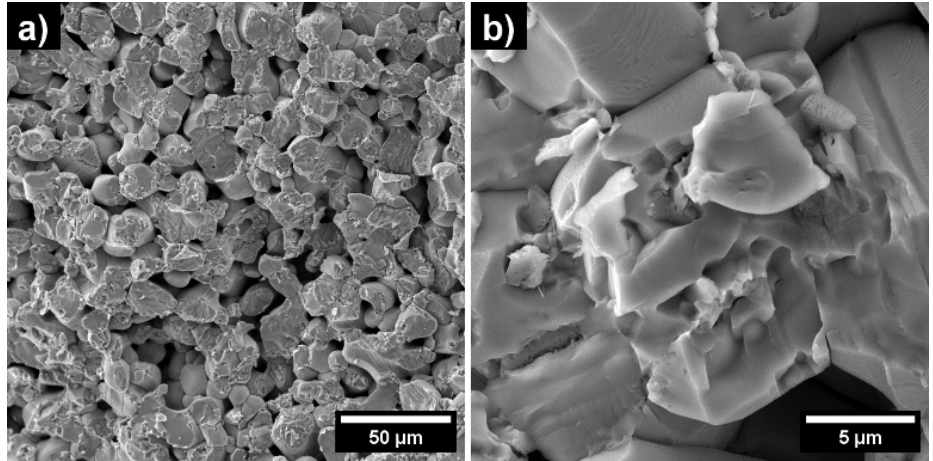
Figure 4. SEM images of the Fe 2 O 3 :ZnO target material with 50 µm ( a ) and 5 µm ( b ) scale bars.